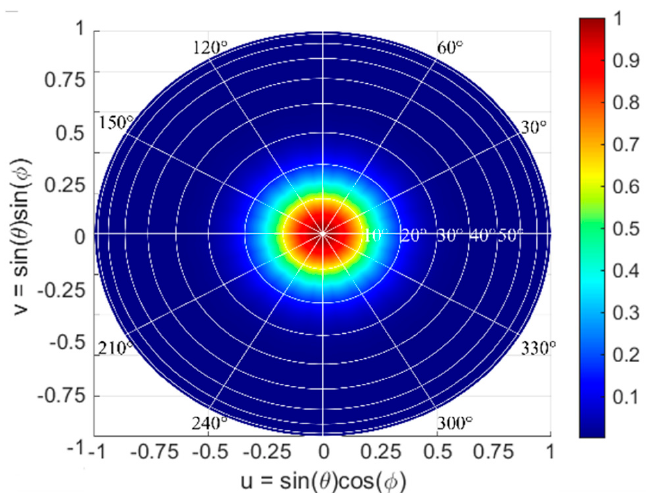
Figure 6. Far-field radiation diagram for a superposition of elliptical Gaussian beams, considering array configuration with M = 11 and N = 10.